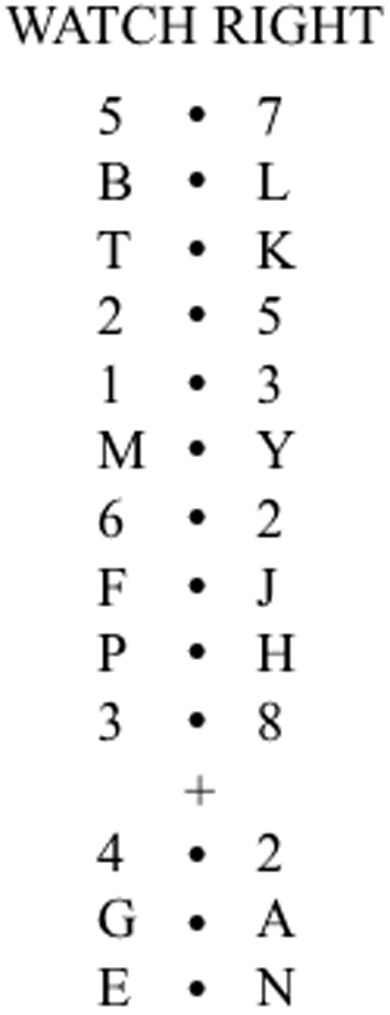
An example of stimuli for one trial as per Duncan et al. (1996). Time runs from top to bottom. “WATCH RIGHT” is presented for 1 s, each proceeding stimulus is presented for 200 ms separated by a blank interval of 200 ms.